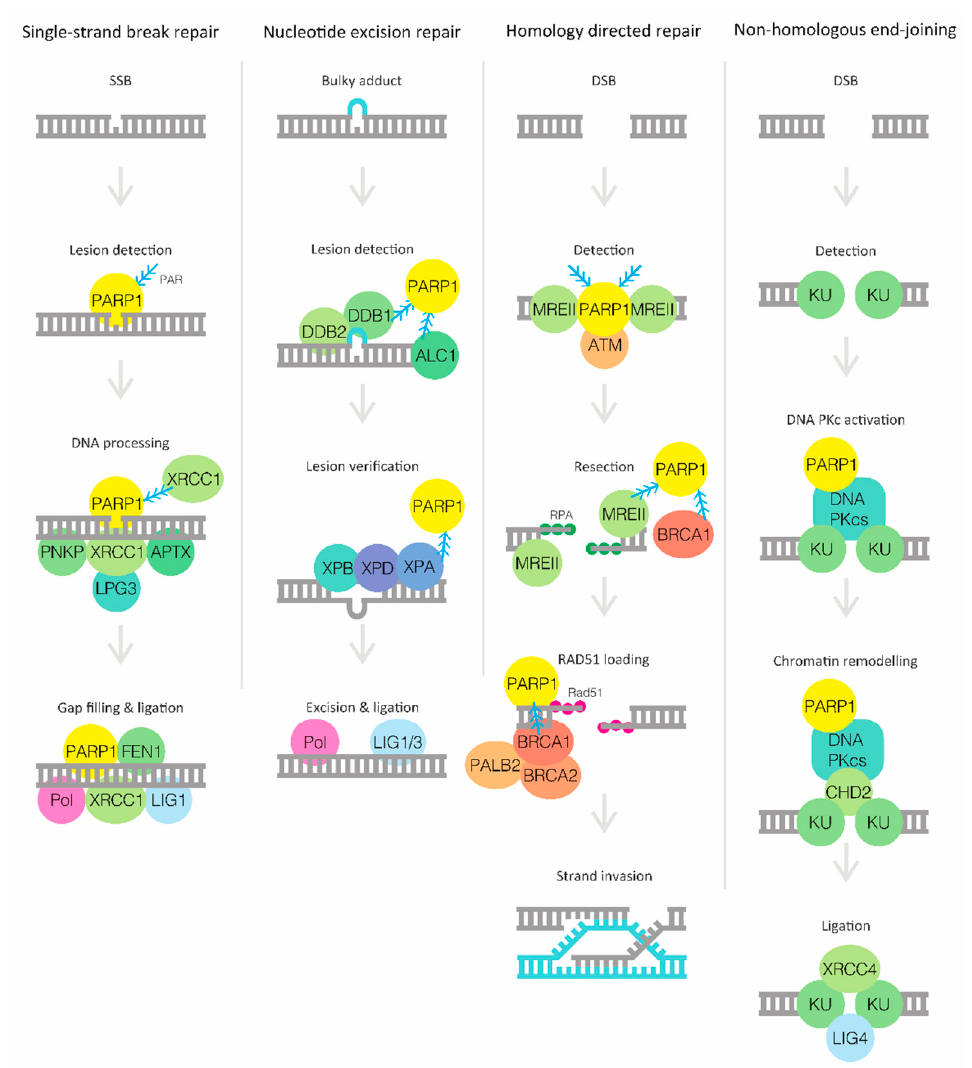
Figure 1. Basic principles and components of major DNA damage response (DDR) pathways in which Poly(ADP-ribose) polymerase 1 (PARP1) has a fundamental role. PARP1 detects the DNA lesion in single strand break repair (SSBR) and in homologous recombination (HR), which is the most common form of homology directed repair [11,20]. PARP1 generally takes part in recruiting repair factors to the lesion site and later interacts with or promotes activity of enzymes during physical repair stage of DDR [12–15,26].